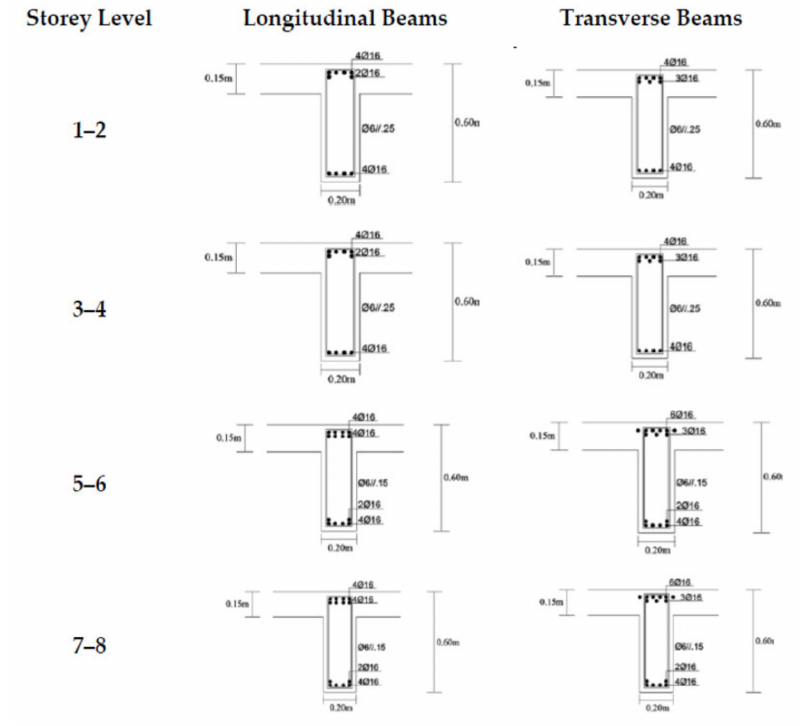
Figure 26. Case study: beams’ cross-sections.